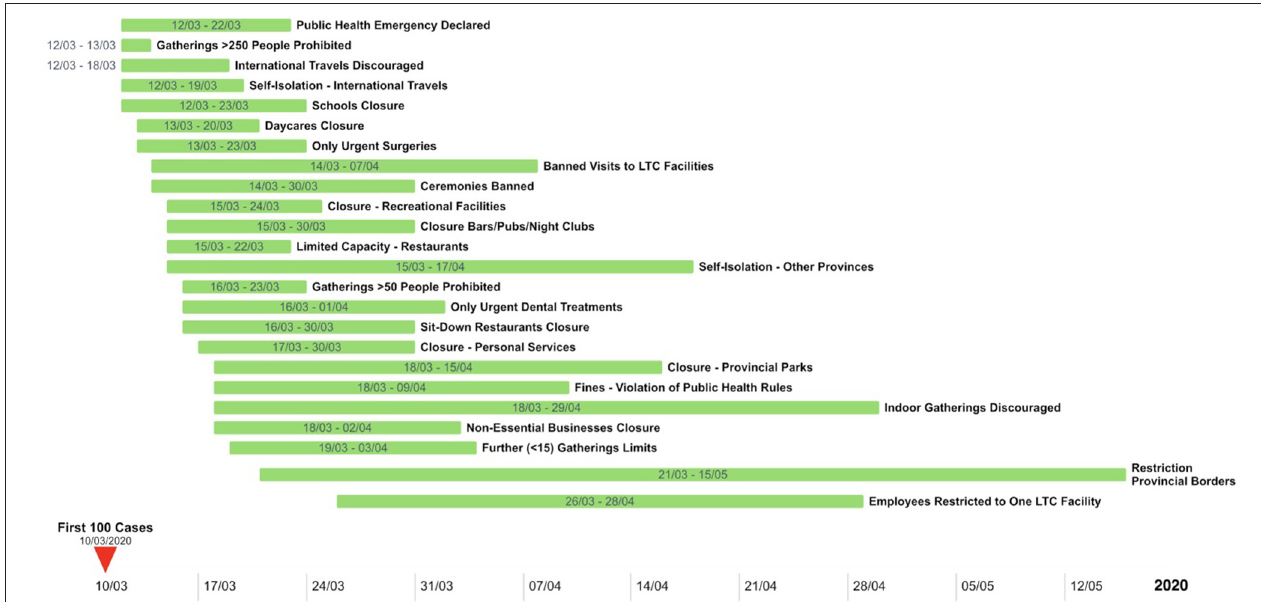
FIGURE 1 | Timeline range of provincial and territorial public health interventions and